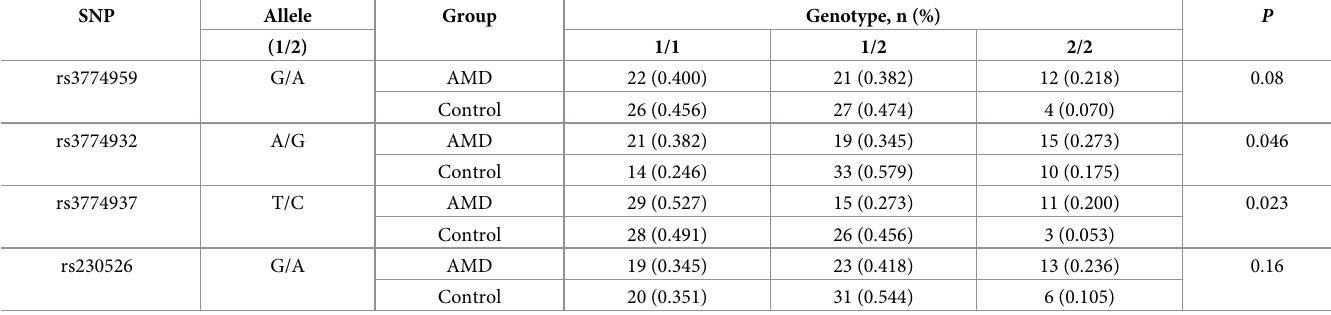
Table 3. Genotype distributions of NF-kB gene polymorphisms in patients with AMD and